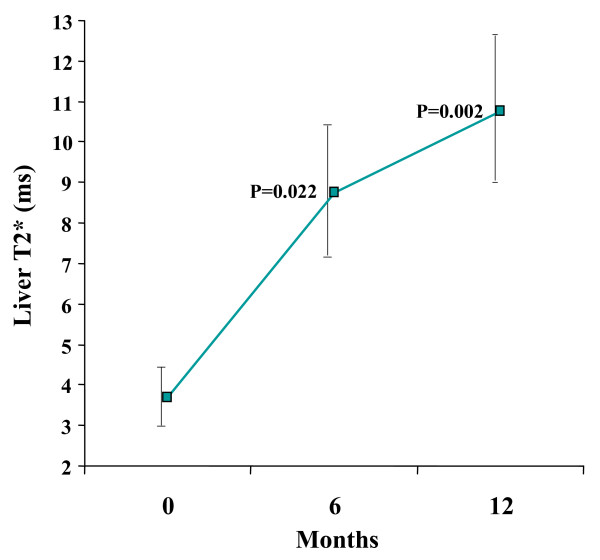
Liver T2* improved significantly between baseline and 12 months. Standard error bars are shown. The p values shown are post-hoc analyses for 0–6 months, and 0–12 months.